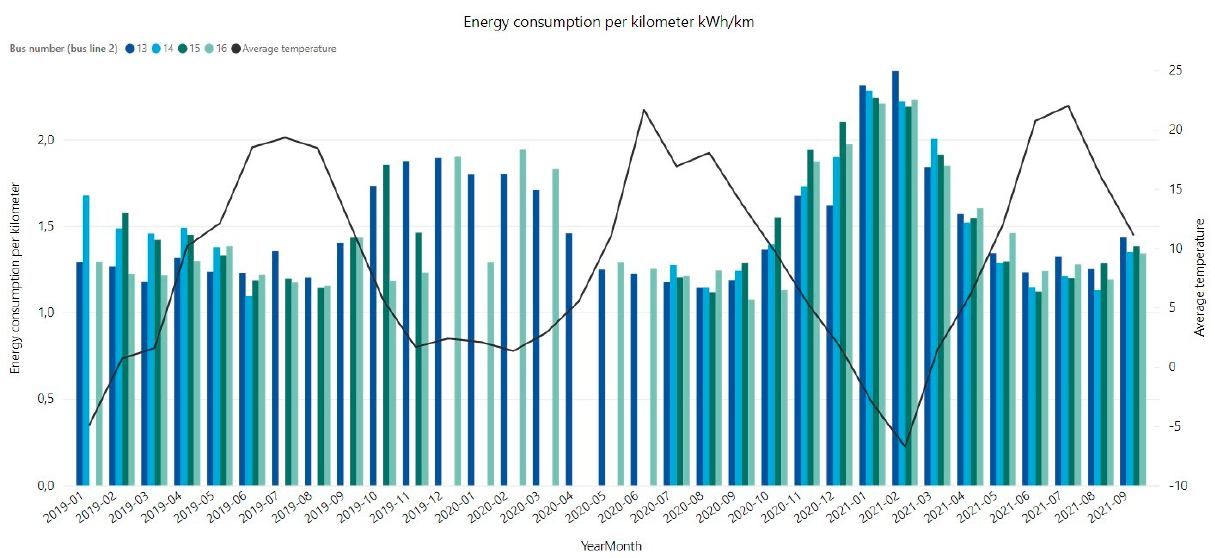
Figure 4. Example of created monitoring dashboards: energy consumption. Disclaimer: The comma is used as a decimal separator instead of a dot because the version of Power BI used in the visualization followed the grammar rules of the Finnish language.